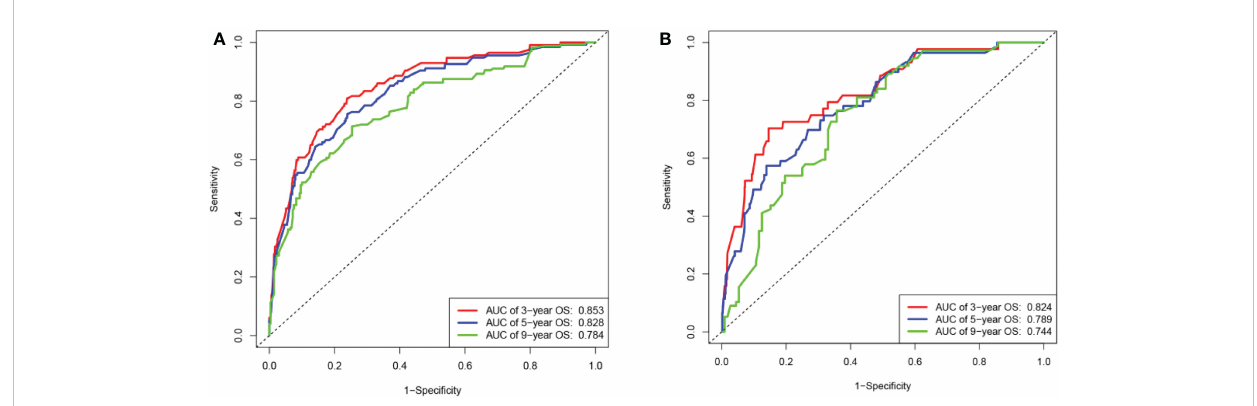
FIGURE 3 The area under the ROC curves for 3-,5-, and 9-year overall survival predicted by the nomogram. (A) Based on the training cohort and (B) on the validation